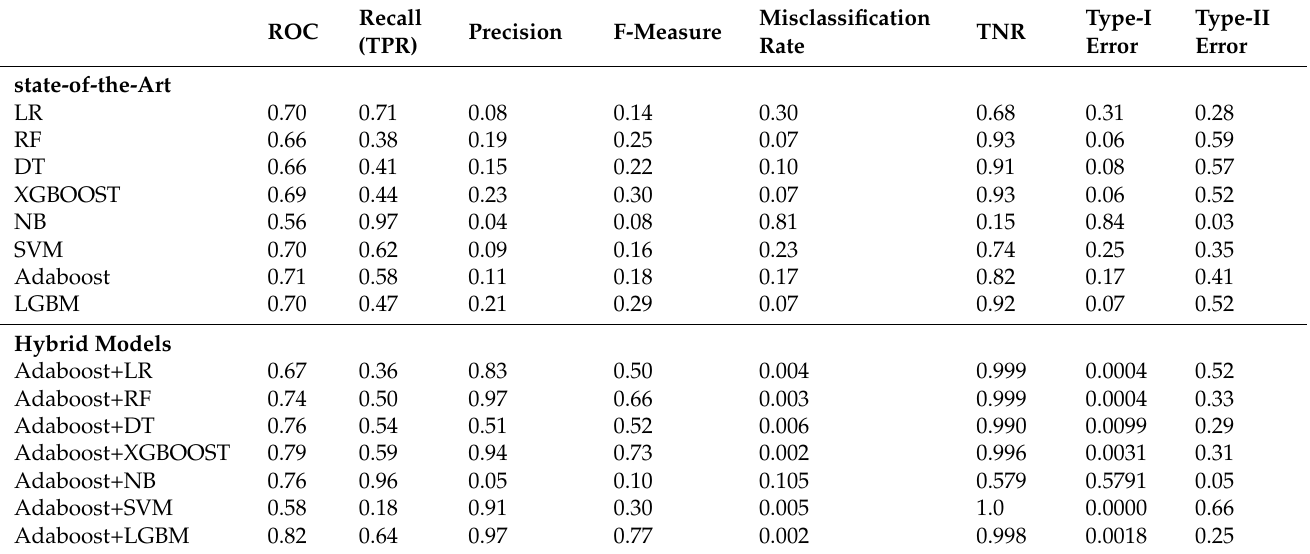
Table 4. Comparison table of the state-of-the-art machine learning algorithms and the proposed hybrid